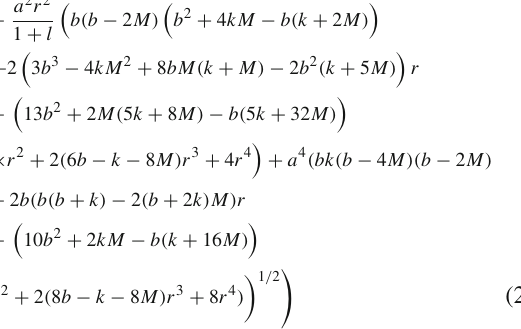
and θ = π with a = 0 . 4 , k = 0 . 2, and l = 0 . 4 6